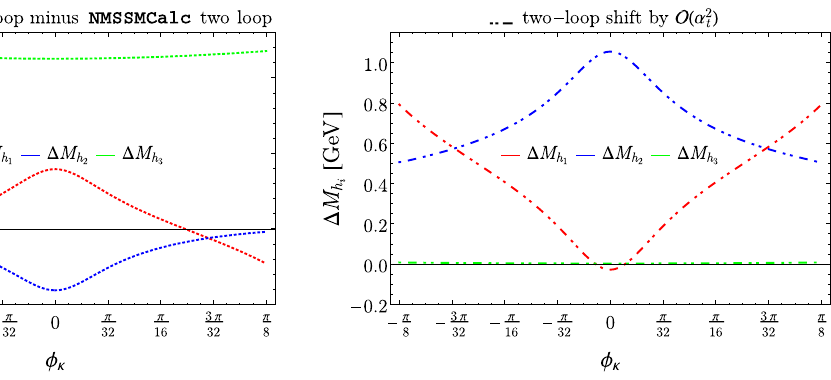
correspondsto (cid:9) (cid:10) i α 2 contributions, which are calculated t